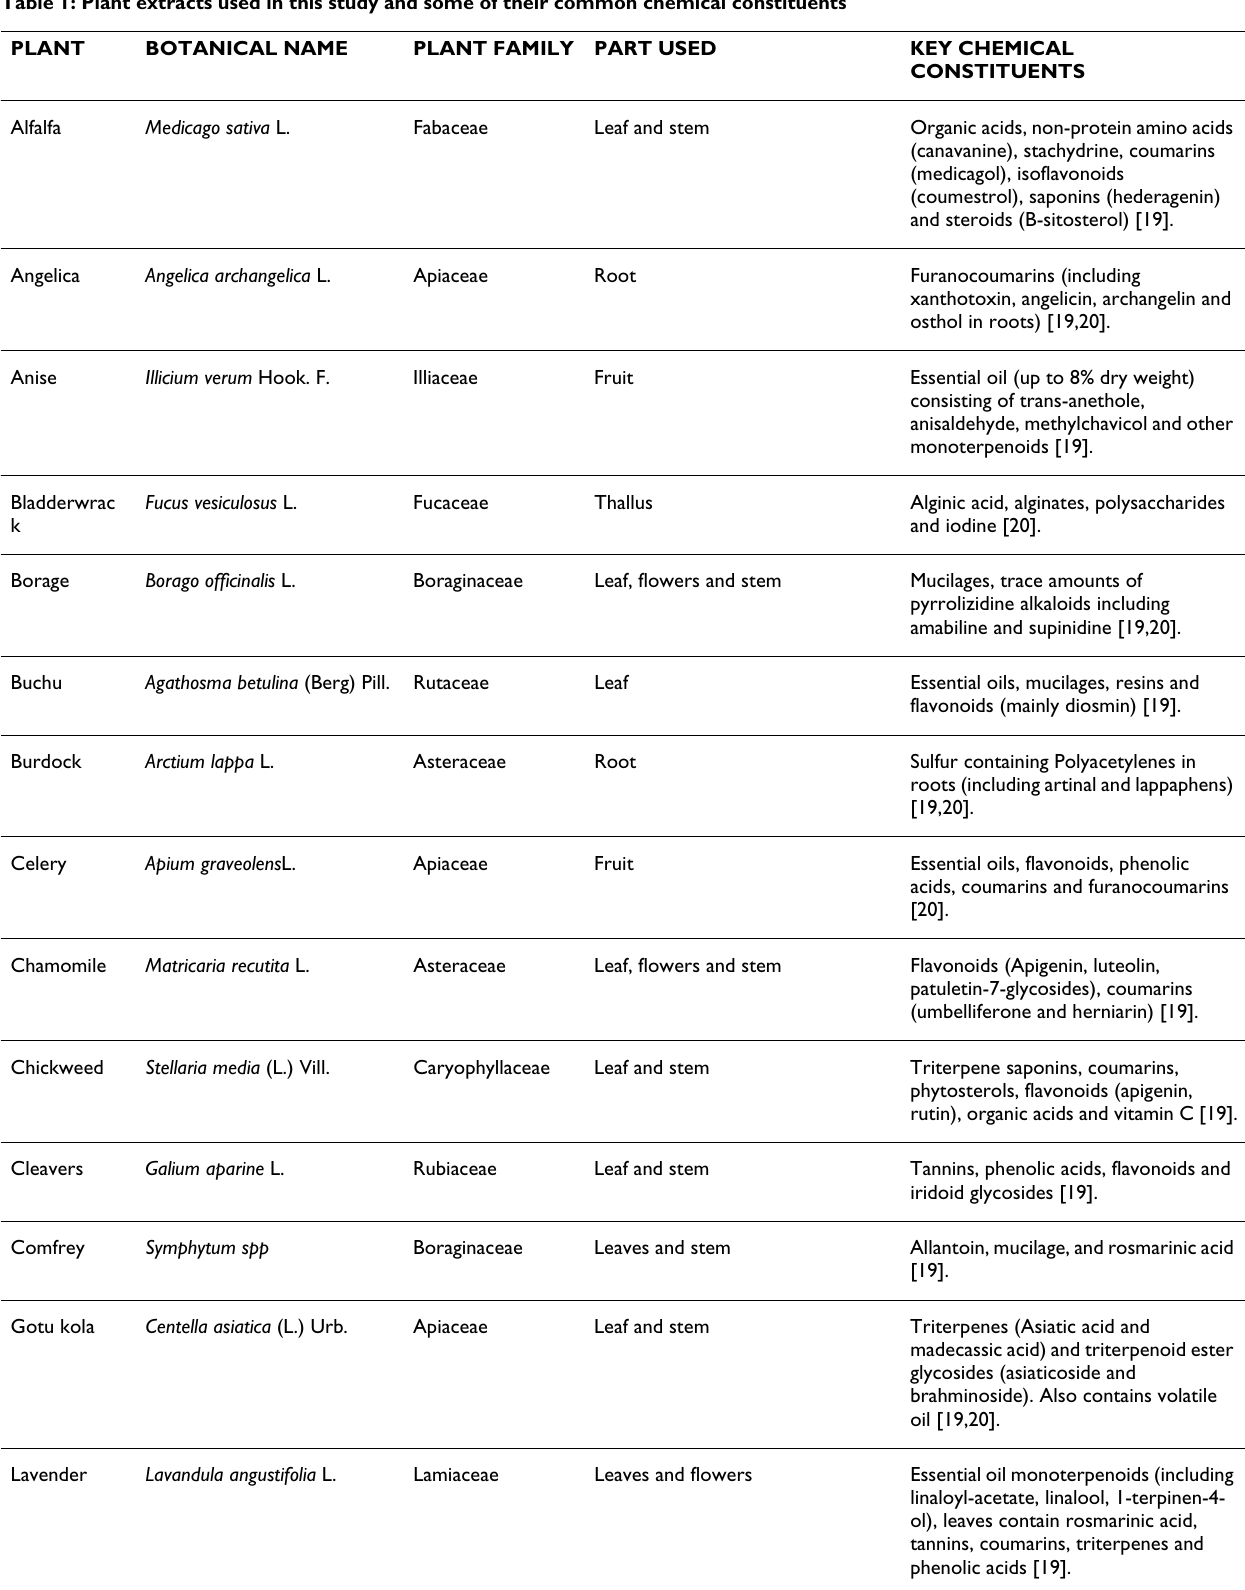
Table 1: Plant extracts used in this study and some of their common chemical constituents PLANT BOTANICAL